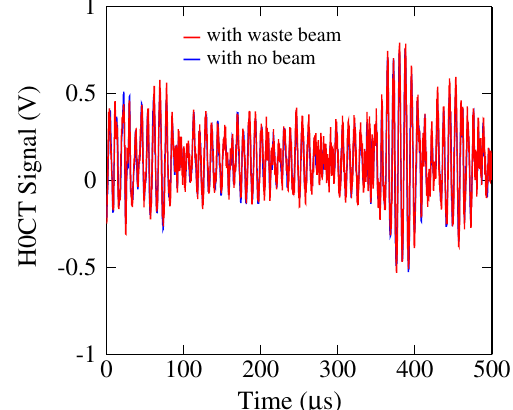
FIG. 5. Signal of the H0CT as a function of the injection time taken in the single-pass extraction mode with beam (red) and with no beam (blue) with an average of 64 shots for the foil and beam positioning as shown in Fig. 4. Data with beam was almost identical to that with no beam at this stage and thus it was hard to extract the real beam signal from this data in order to estimate the waste beam.